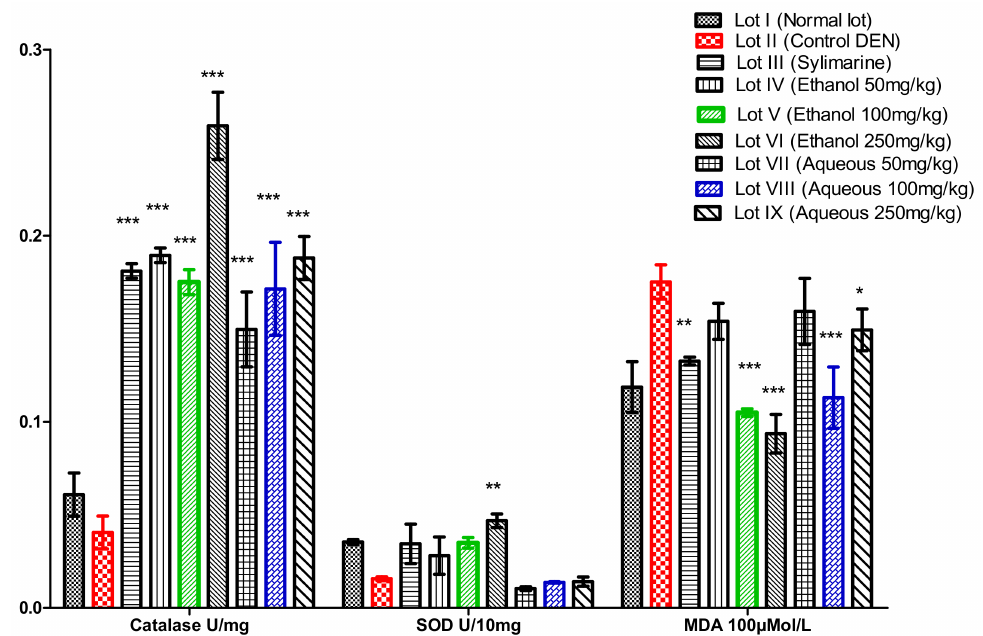
Figure 1. Variation of catalase, superoxide dismutase and malondialdehyde; p > 0.05: the difference is not significant; 0.05 > p > 0.01: the difference is significant *; 0.05 > p > 0.001: the difference is highly significant **; p < 0.001: the difference is very highly significant ***. Compared with the positive control (diethylnitrosamine